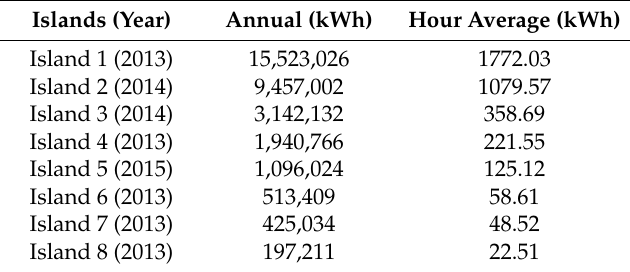
Table 1. Annual and average hourly generation of